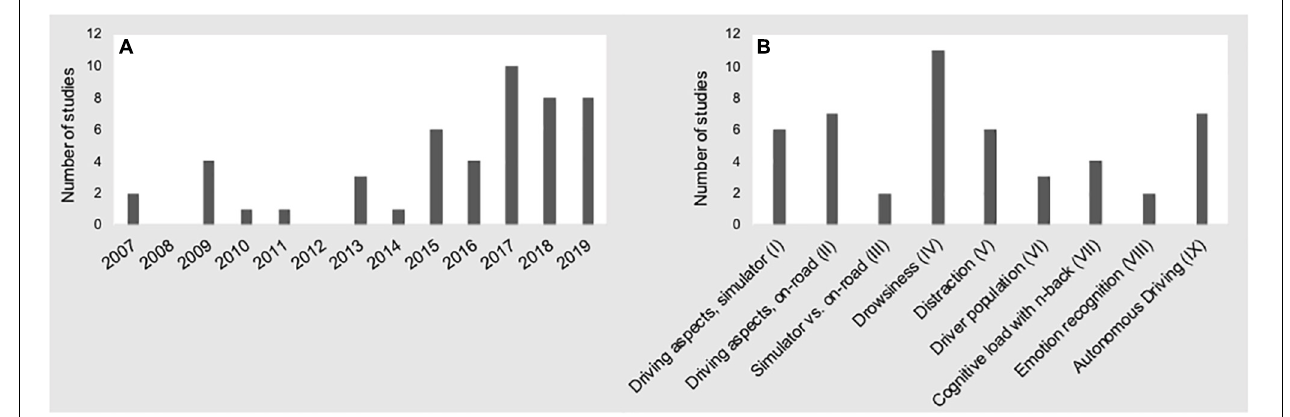
FIGURE 3 | Number of fNIRS driving studies conducted from 2007 to 2019 (A) , and research topics (B)